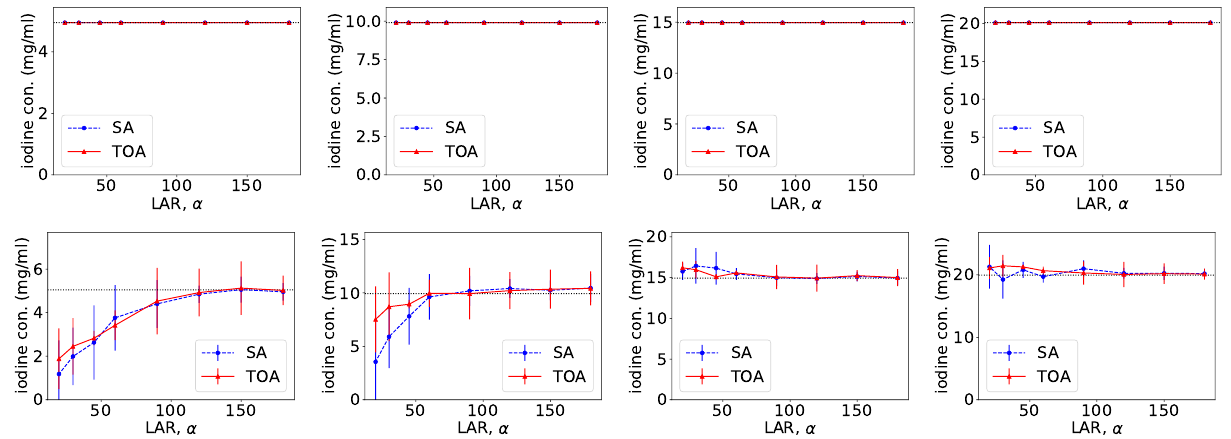
Figure 6. Iodine concentrations, along with their respective error bars, in ROIs 1–4 (from left to right) within the chest phantom, as functions of LARs α τ for SA (blue, dashed) and TOA (red, solid) scans, estimated from basis images reconstructed from noiseless (row 1) and noisy (row 2) data by use of the two-step